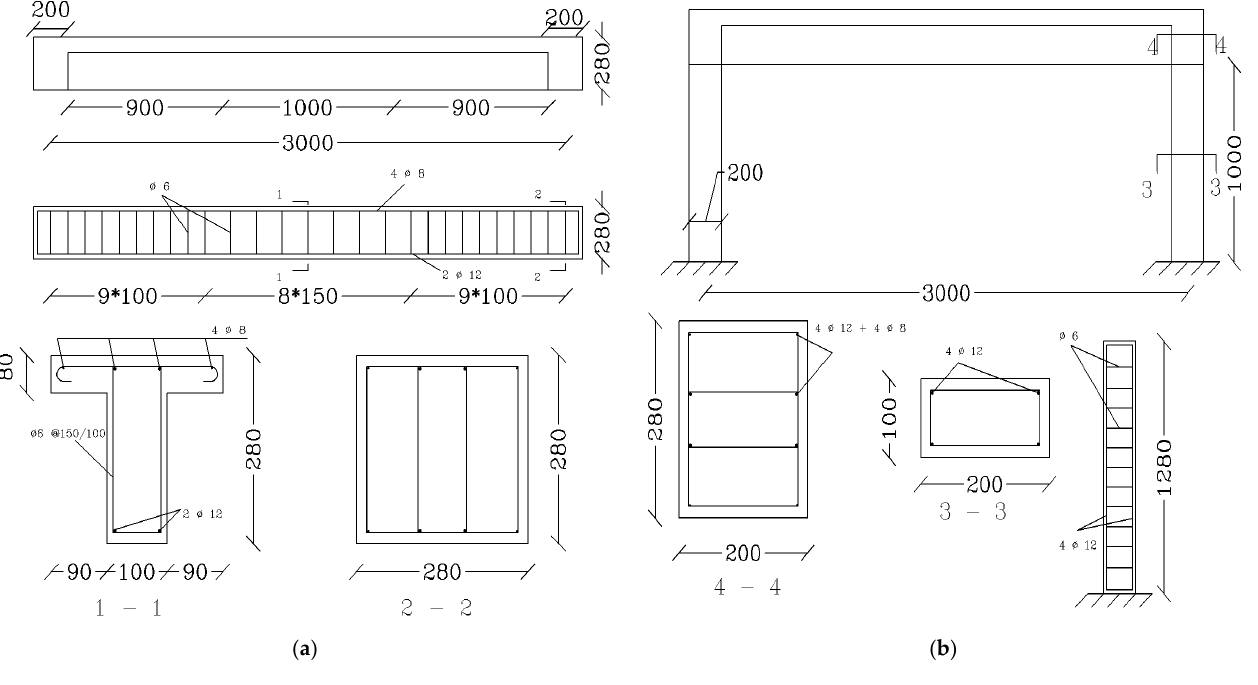
Figure 2. Sample design: ( a ) beam [1]; ( b ) column